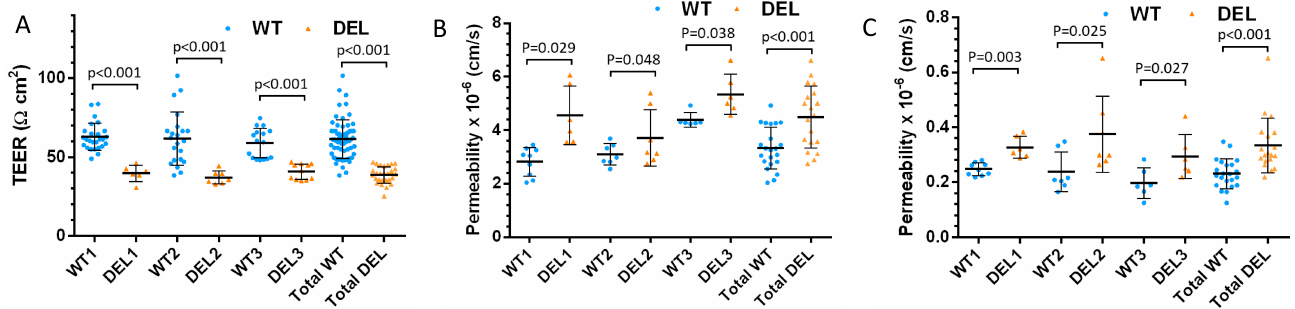
Figure 1. Comparison of barrier function of the iBBB between control (WT) and 22q11.2DS-SCZ (DEL). TEER ( A ), Perme- ability to a small solute, NaFl ( B ), and to a large solute, Dex-70K ( C ), for 3 paired control and 22q11.2DS-SCZ samples. Values are mean ± SD. n ≥ 6 for each case were from at least 3 independent experiments (differentiations).